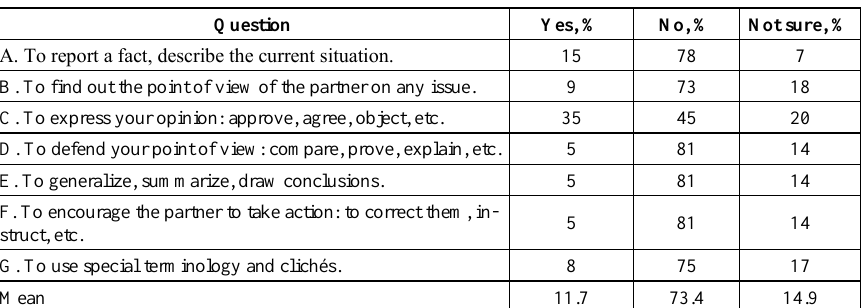
Table 6. Importance of the ability to conduct a business conversation with a business partner in a foreign language Question Yes, % No, % Not sure,